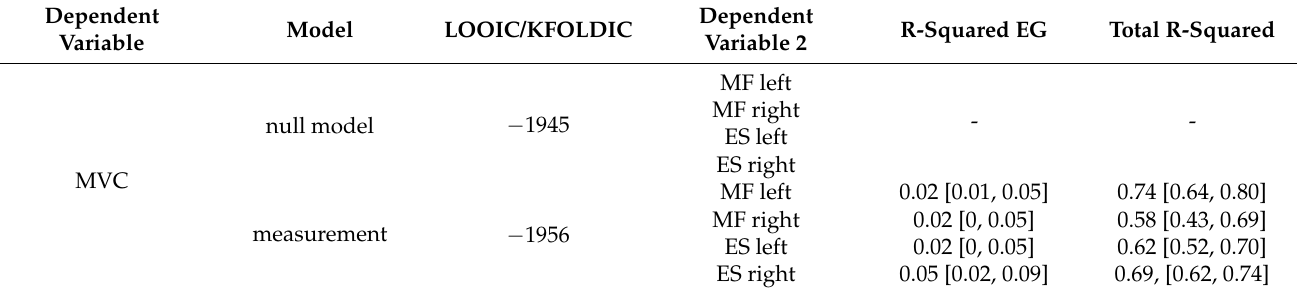
Figure 5. Results of hierarchical four-dimensional lognormal regression analysis with MVC as the dependent variable and the measurement as the main effect in the study group. Left panels: a posteriori distributions of regression coefficients. The shaded areas represent 95% confidence areas. Right panels: estimated marginal means. The points represent means of a posteriori distributions, whereas vertical lines indicate 95% confidence intervals. Table 1. Summary of regression models’ fitness to the data used for testing the research Hypothesis